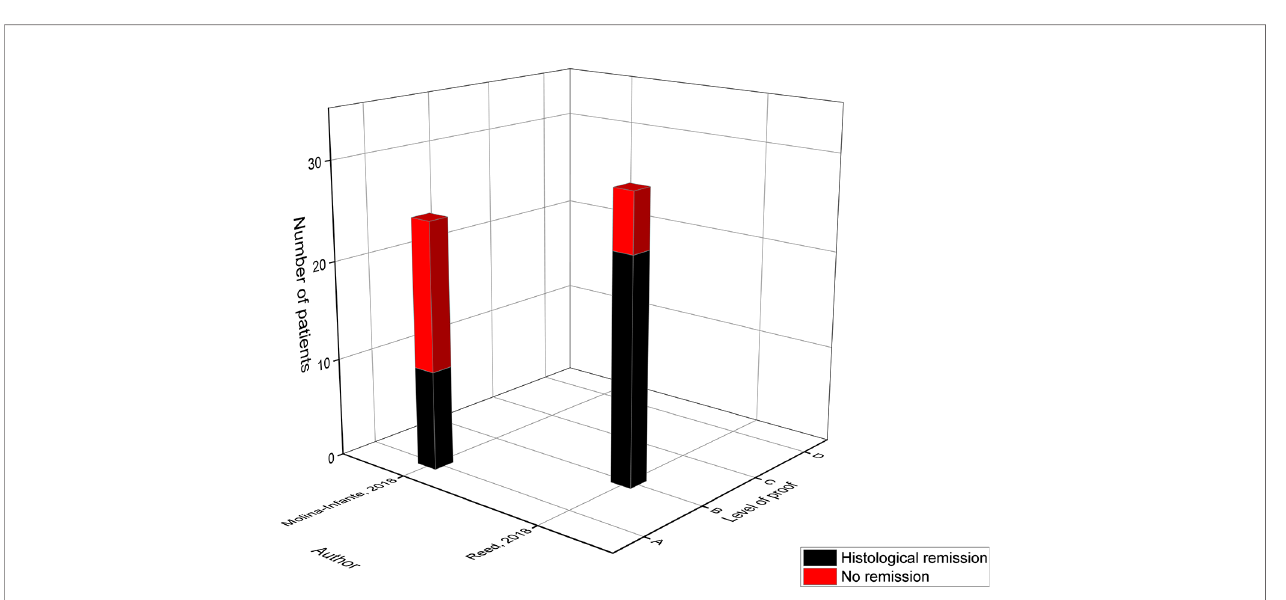
FIGURE 6 | Level of proof of studies on the 2-food elimination